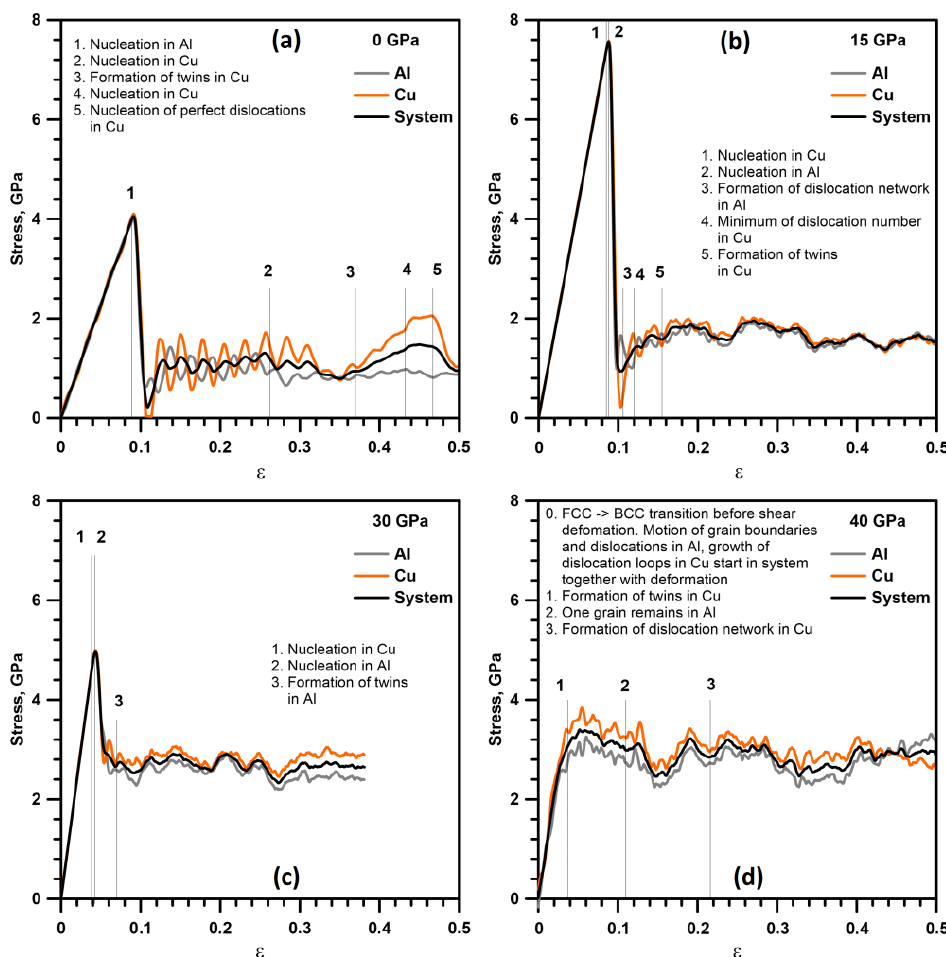
Figure 2. Shear stresses in a bisystem as a function of strain at different initial pressures: ( a ) 0 GPa, ( b ) 15 GPa, ( c ) 30 GPa, and ( d ) 40 GPa. The black line corresponds to the stress averaged over the bisystem, the orange line corresponds to the copper part, and the gray line corresponds to the aluminum part; the strain rate is 10 9 s − 1 and the temperature is 300 K. Numbers indicate the structural transformations described in the